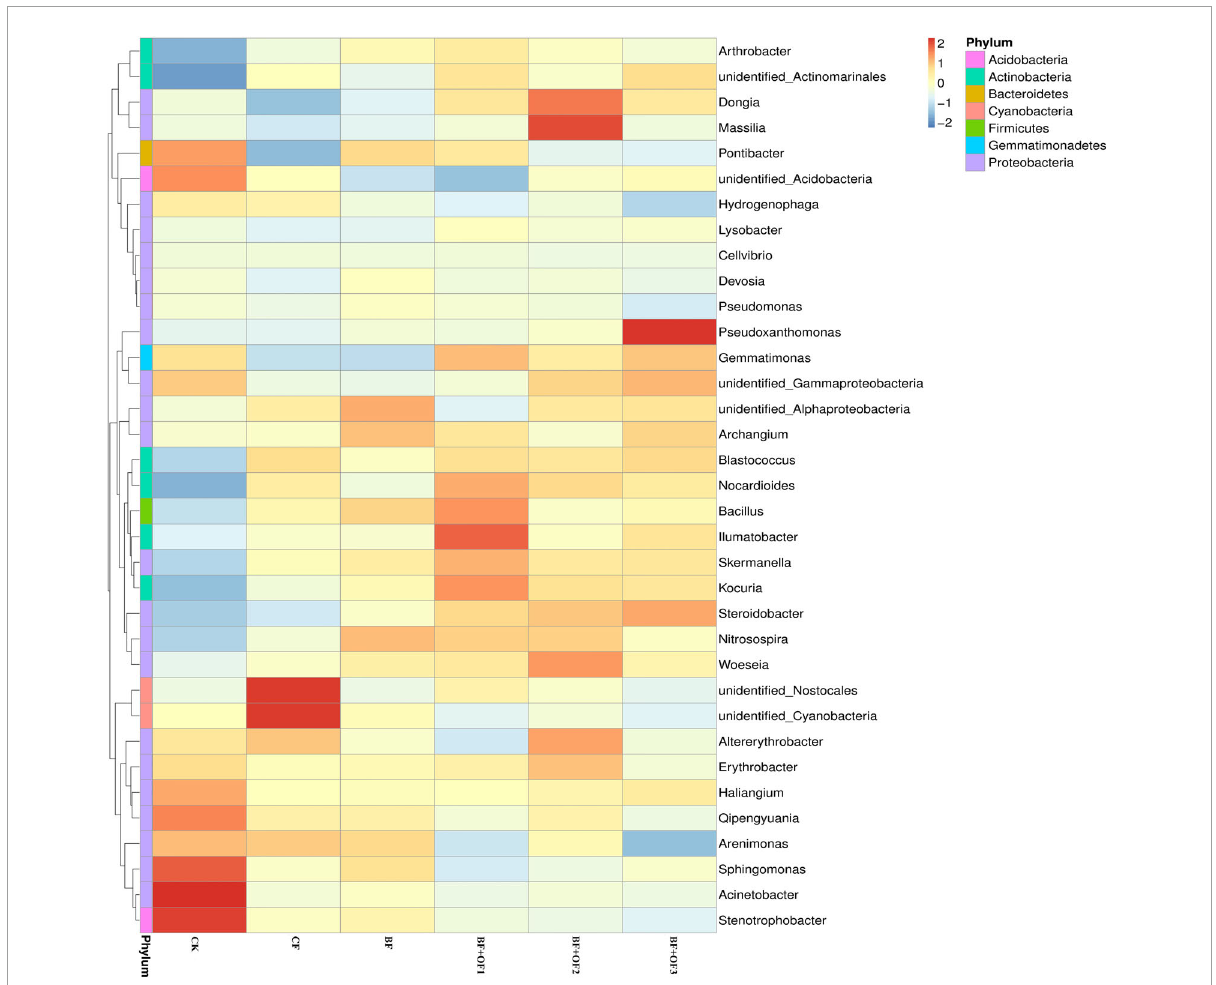
FIGURE5 Heat map analysis of bacterial community in soil of different fertilization treatments. CK, no fertilizer, CF, chemical fertilizers (conventional dosage for this region); BF, balanced fertilizer (70% of total chemical fertilizer); BF + OF1, BF + OF2, and BF + OF3, balanced fertilizer plus 3,000, 6,000, and 12,000 kg.ha − 1 bio-organic fertilizer, respectively. (Colors from blue to red represent that the relative abundance of the community from low to